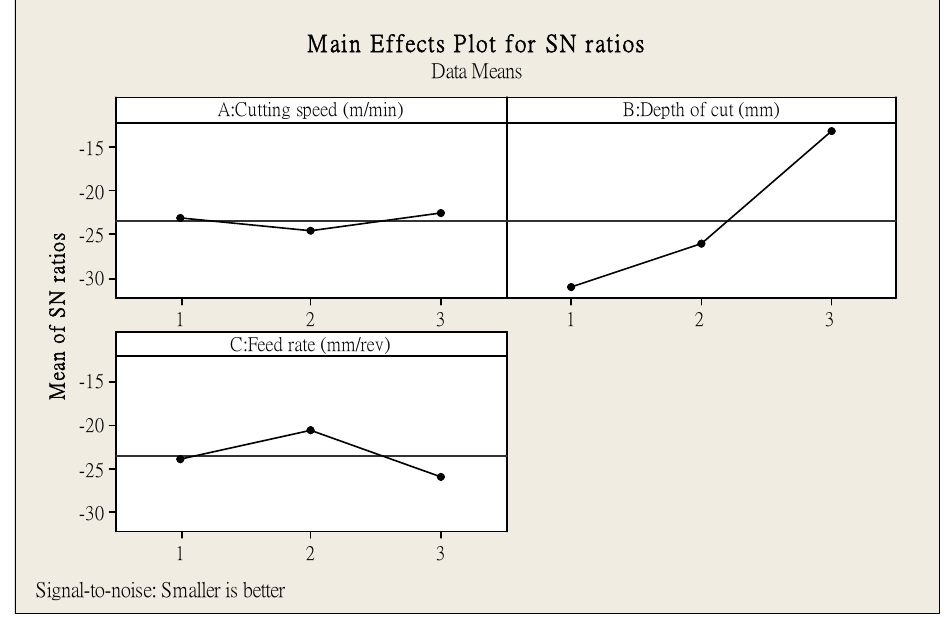
Figure 6. Main effects plot of the SNR (smaller-the-better).